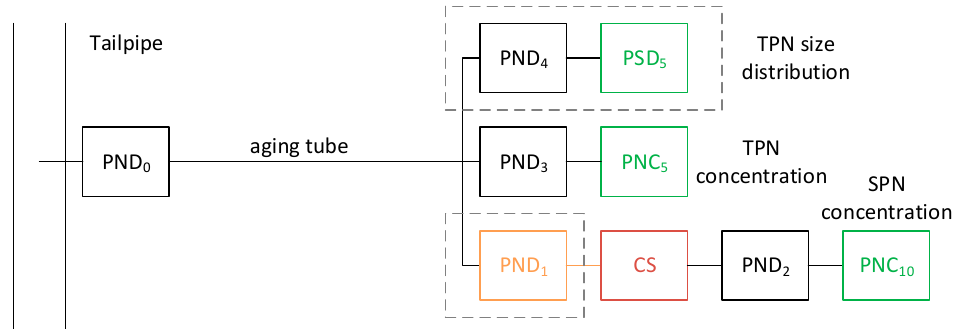
Figure 2. Recommended setup for measurements of solid and total particles. Red temperature > 300 °C. Green particle detectors. Dashed lines indicate optional parts. CS = catalytic stripper; PNC = particle number counter; PND = particle number diluter; PSD = particle size distribution instrument; SPN = solid particle number; TPN = total particle number.